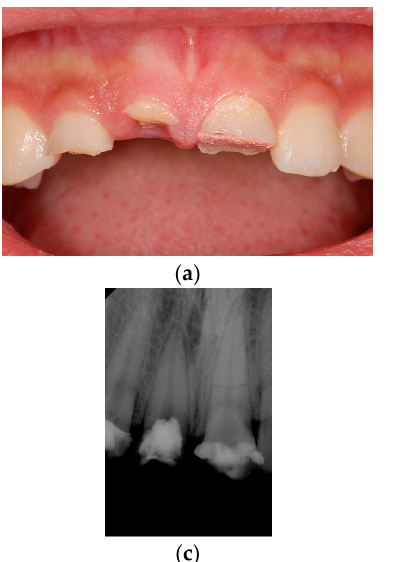
Figure 1. Clinical photographs and a periapical radiograph taken at the initial visit; ( a ) Frontal view; ( b ) Occlusal view; ( c ) Periapical radiograph. ( b ) Occlusal view; ( c ) Periapical